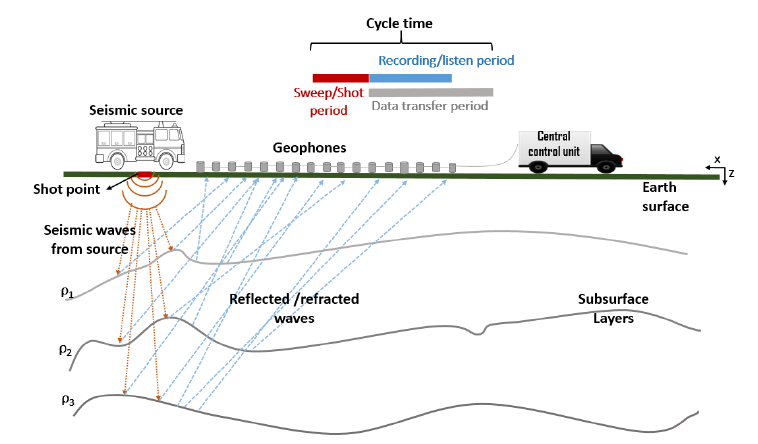
Figure 1. An onshore seismic survey